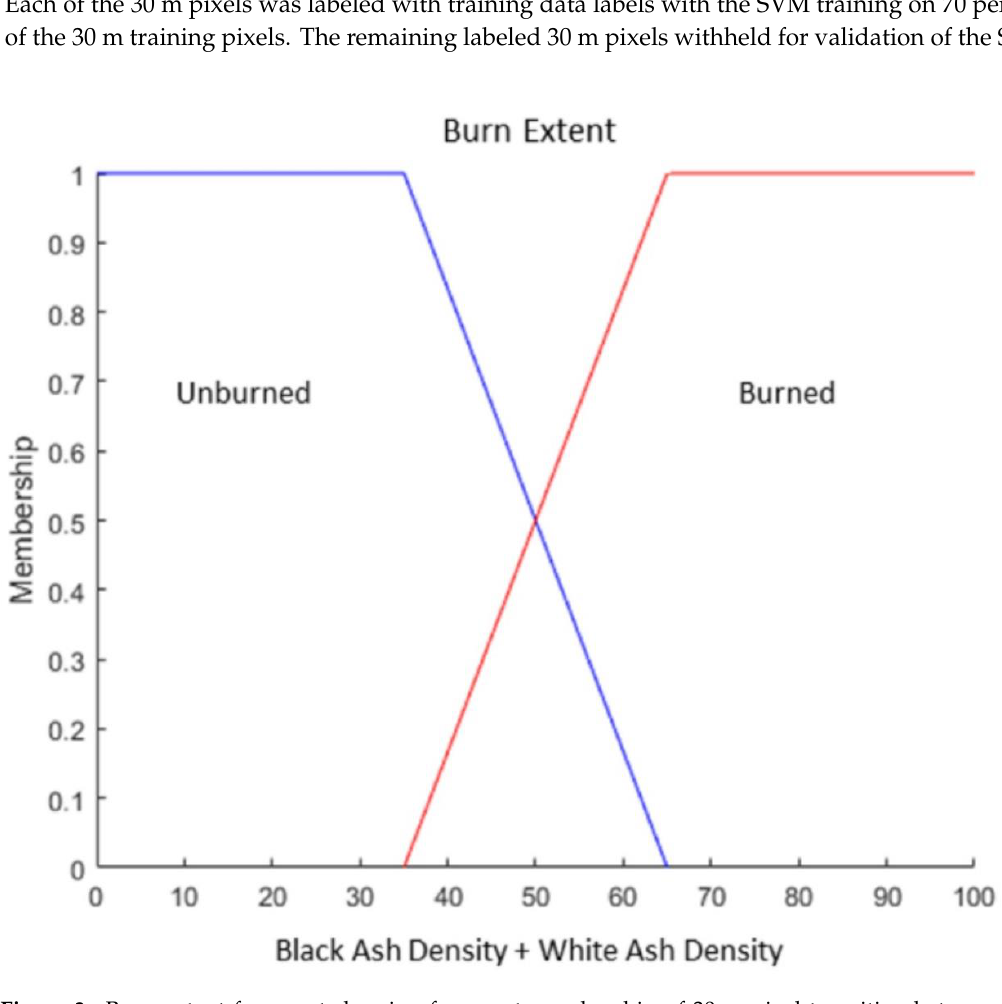
Figure 3. Burn extent fuzzy set showing fuzzy set membership of 30 m pixel transition between Unburned and Burned from 35 to 65 percent of 5 cm pixels being classified as burned.